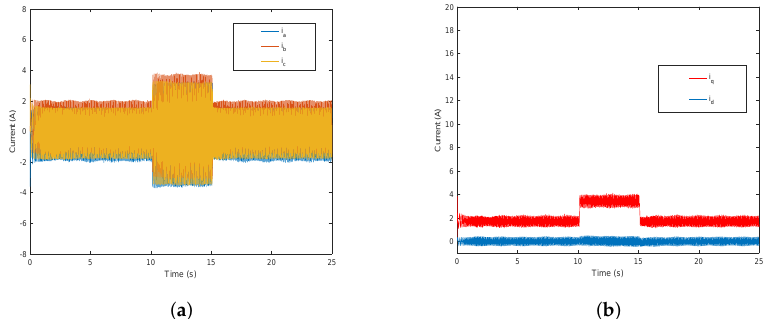
Figure 11. Experimental current curves based on PI method under load disturbance. ( a ) three-phase current response curves; ( b ) d - q axis current response curves.